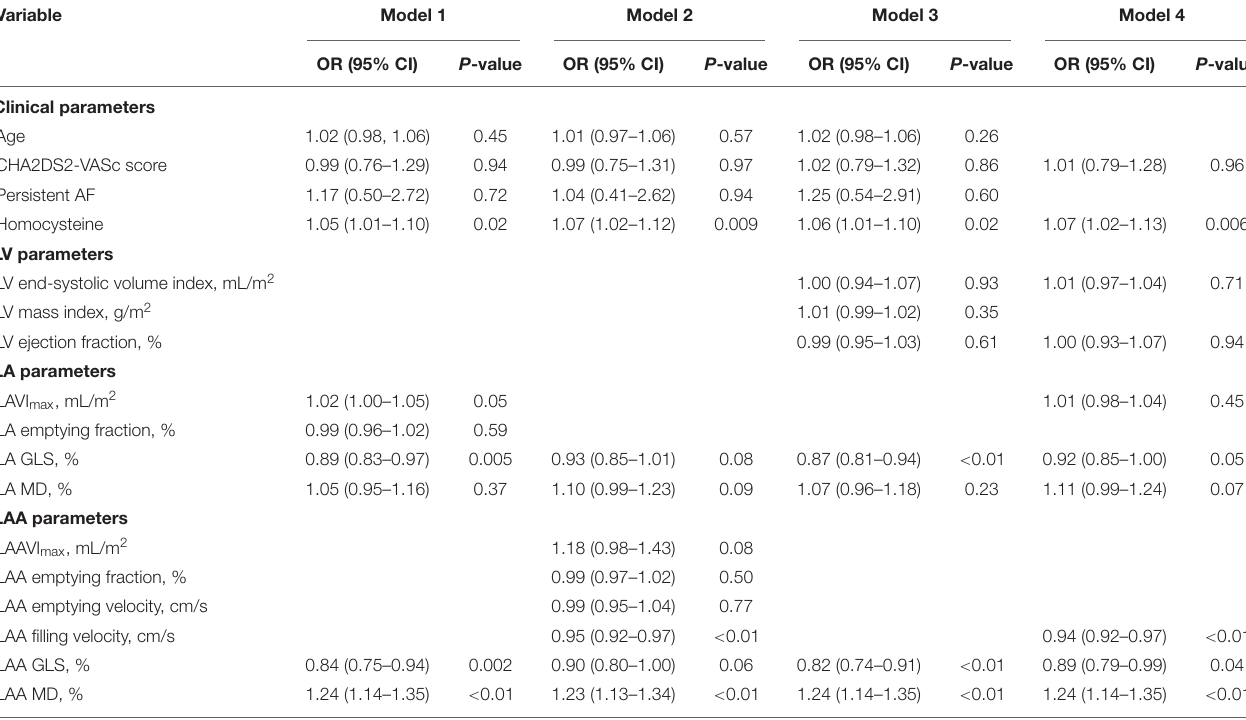
TABLE 4 | Multivariate analyses of associations with LAA dense SEC or